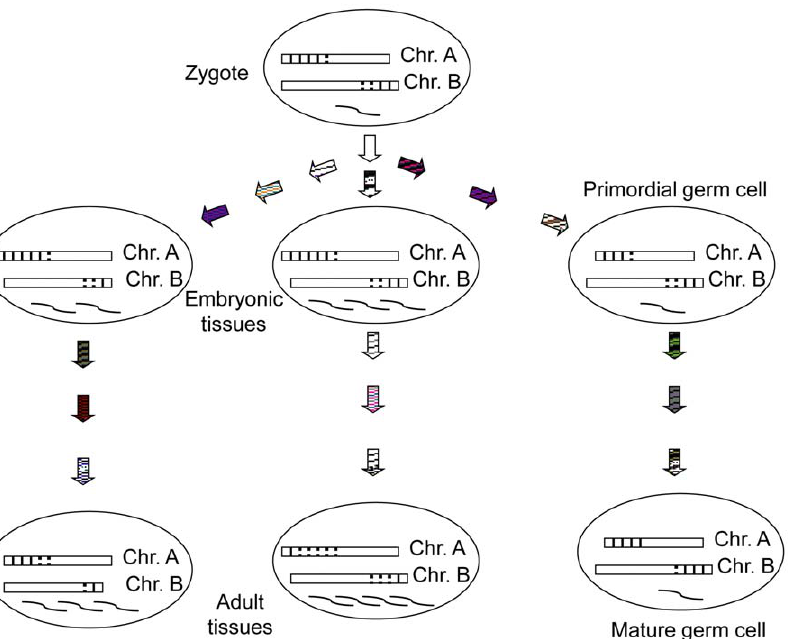
Figure 7. Proposed model for ontogeny-induced rDNA rearrangement, methylation, and transcription. Different cell lineages undergo serial stages of rDNA genetic/epigenetic and transcriptional modifications, as indicated by vertical bars for two haplotypes (broken: hypomethylated; solid: hypermethylated) in multiple chromosomes (Chr.) and helical lines, respectively. These rDNA activities, including copy number changes, are driven by distinct stage-dependent ontogenic stimulants, represented by arrows with diverse